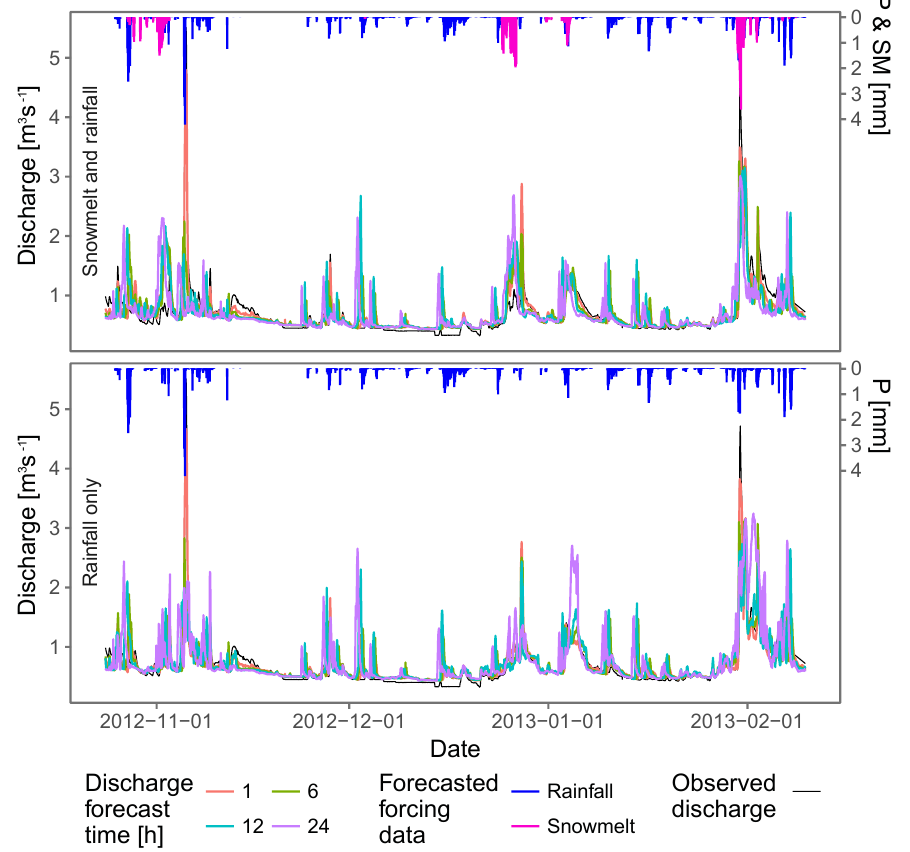
Figure 7. Forecasted discharge at four forecast times ( t = 1, 6, 12, 24 h) for the snowmelt and rainfall models ( top panel) and for the rainfall only models ( bottom panel). P stands for rainfall and SM stands for snowmelt in the right hand side vertical